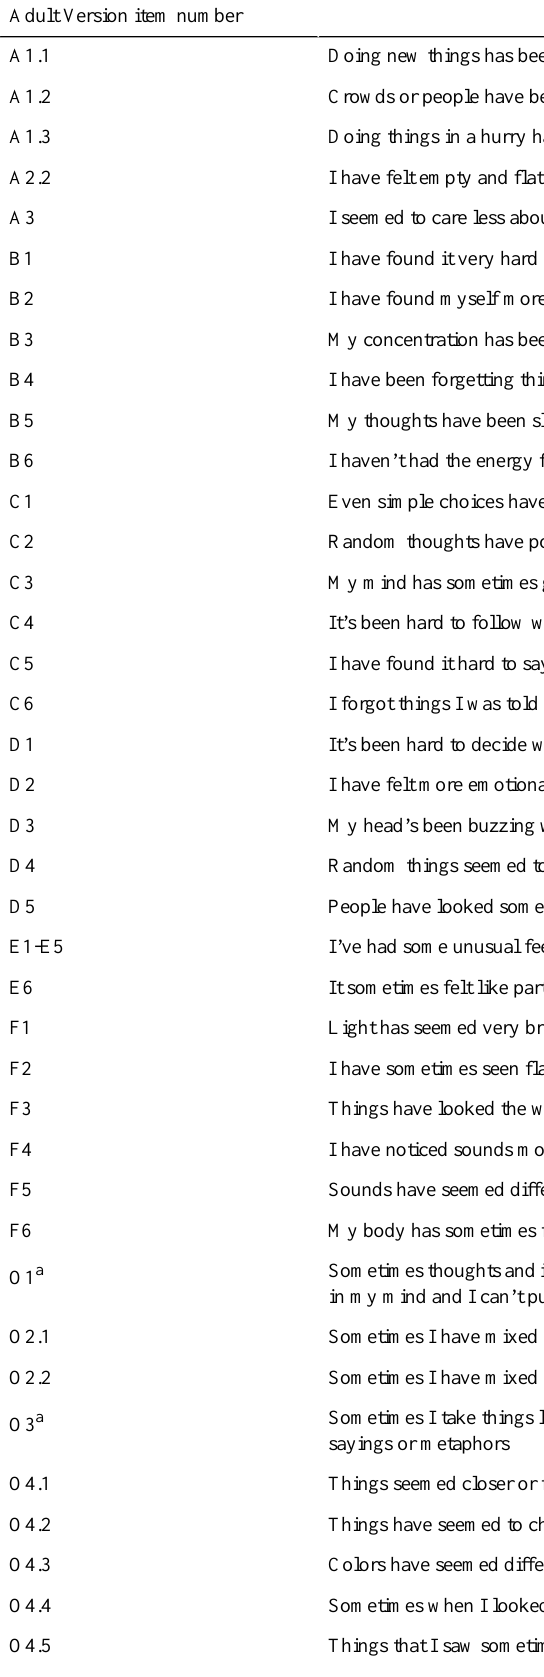
Table 3. Basic symptoms checklist item pool, with corresponding Schizophrenia Proneness Instrument Adult Version item numbers. Basic symptom checklist item wordingSchizophrenia Proneness Instrument Adult Version item